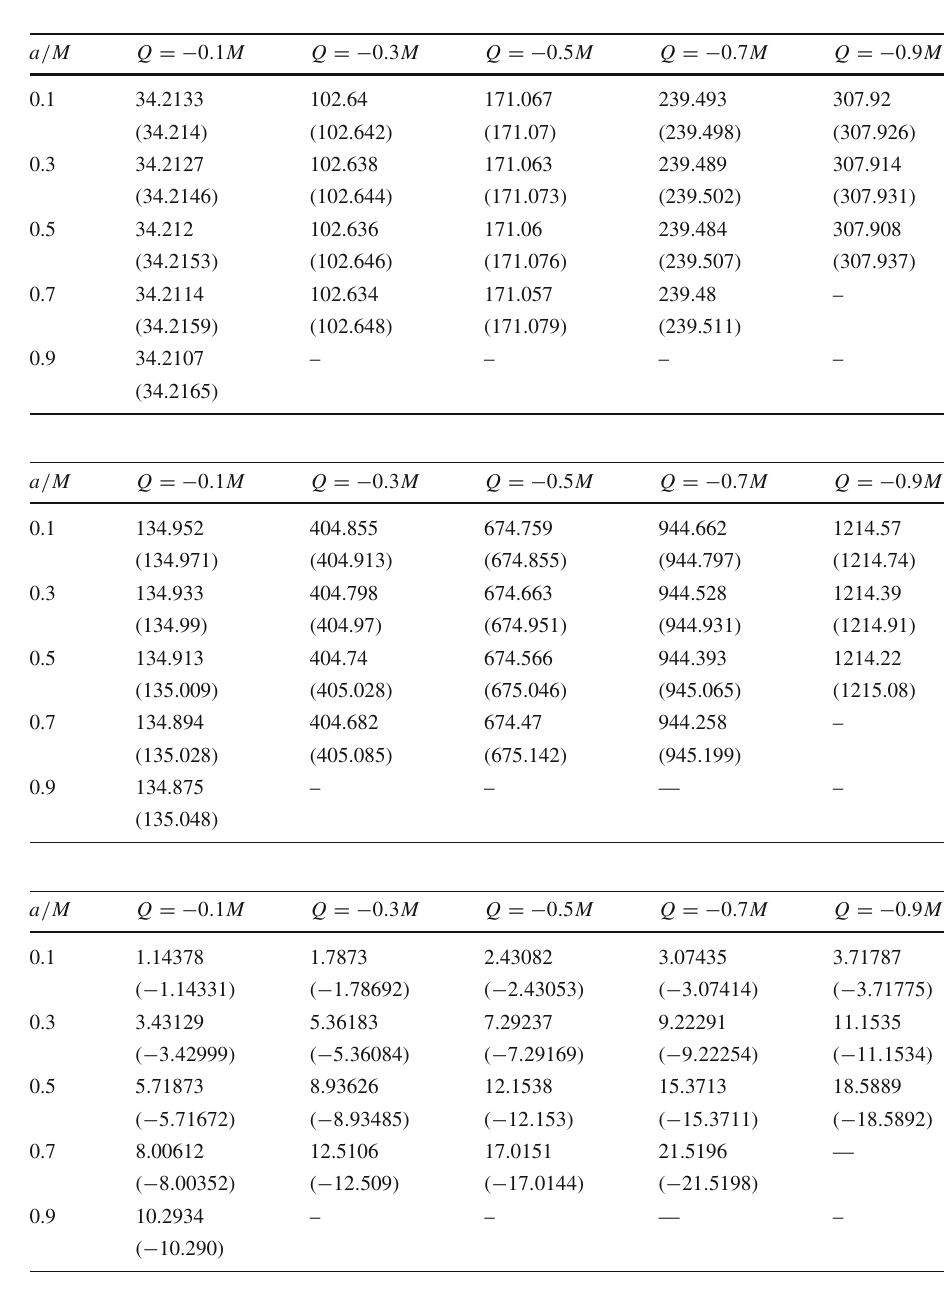
photons (cf. Table 1). Interestingly, the black hole rotation weakens the gravitational field as the rotating black holes lead to smaller deflection angle compared to the nonrotating black holes for the prograde photons (cf. Table 3). On the other hand, the retrograde photons experience larger deflec- tion angle around the rotating black hole in comparison with the nonrotating black holes (cf. Table 3). The absolute cor- − α ) | from the nonrotating rection | δα D | = | (α D | D NR